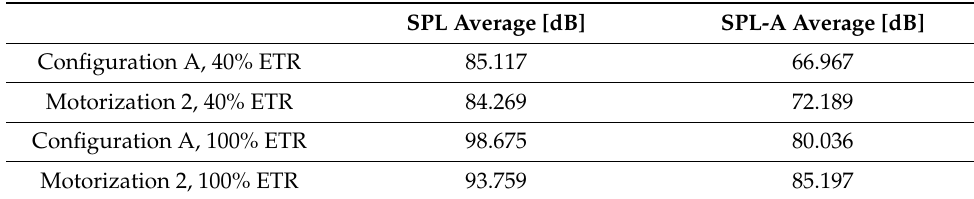
Figure 29. Comparison between Configuration A and Motorization 2; OASPL values on the transverse YZ plane ( a ), A- weighted values on ( b ). Flight condition Climb 100% ETR.